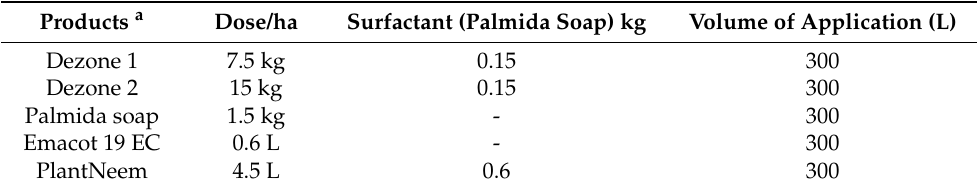
Table 1. Preparation of different insecticide solutions tested during the